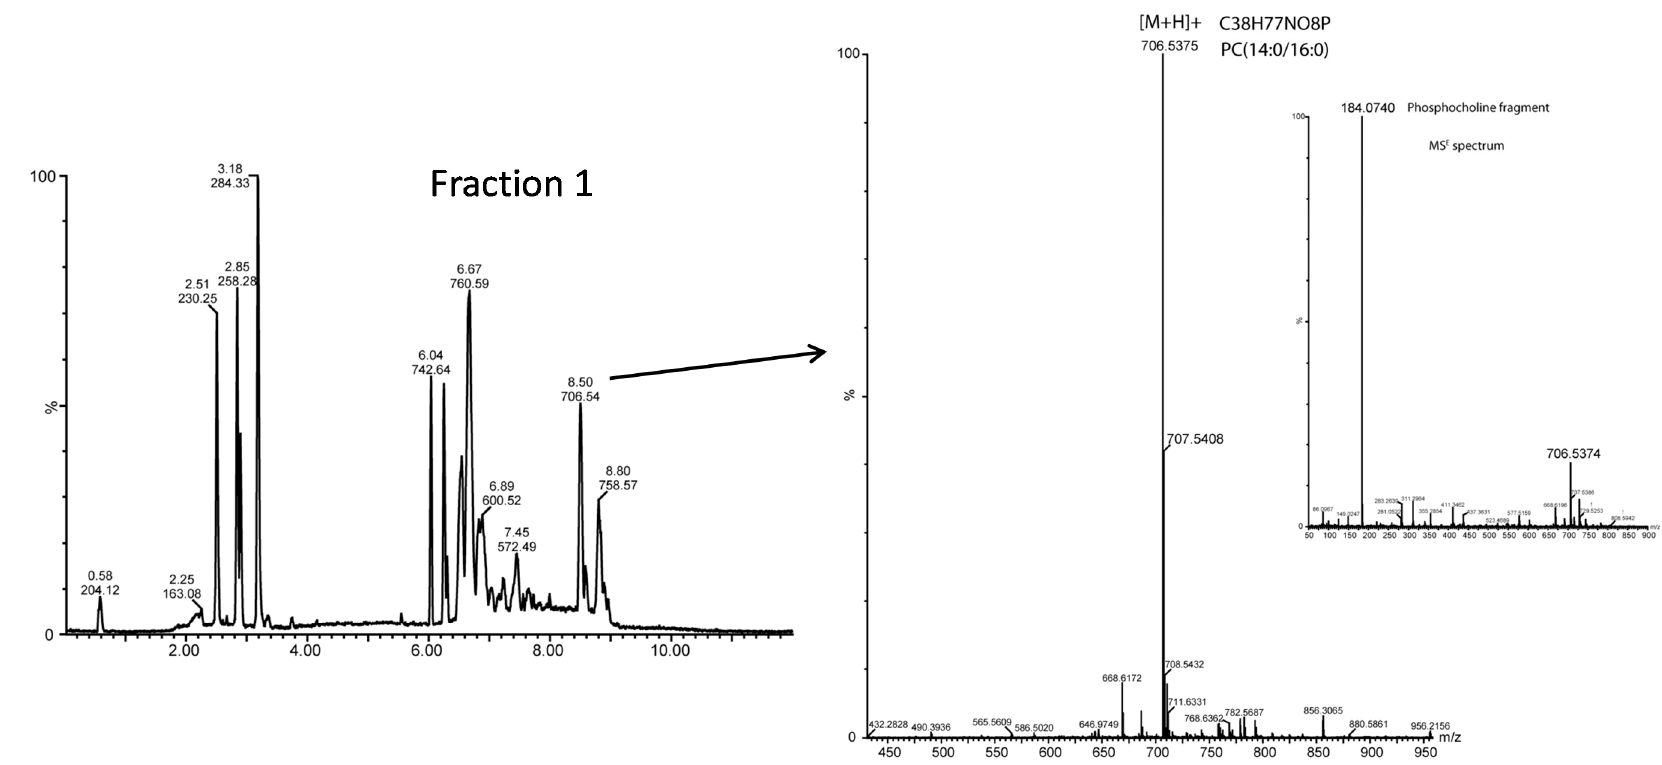
Figure 3. Positive ion mode spectrum of m / z 706.54 corresponding to PC (14:0/16:0) and the phosphocholine fragment obtained in the MS E (high energy function) spectrum of Fraction 1 of buttermilk by UPLC-QToF-MS.